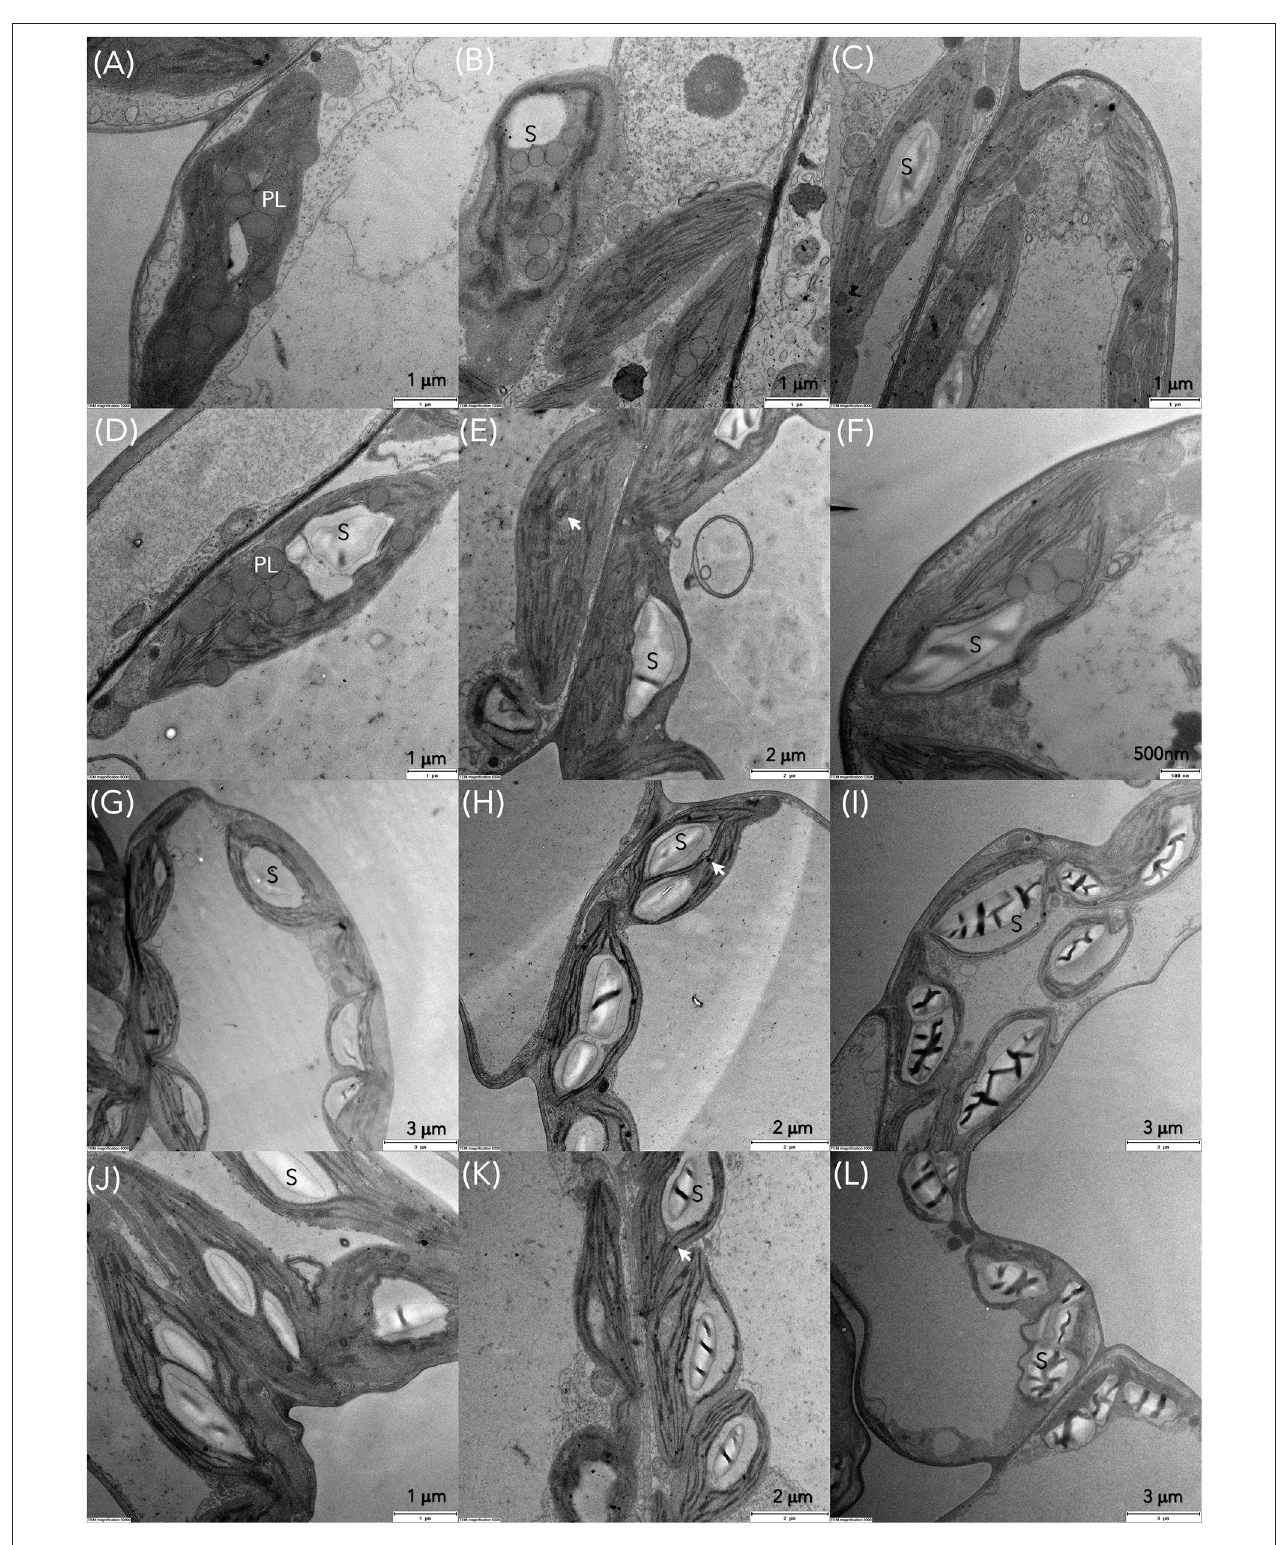
FIGURE 7 | Transmission electron microscopy (TEM) images of S. polyrhiza mother fronds (MFs) after exposure for 6, 24, and 72h to Cd concentrations (A–C) C1 and (D–F) C3 and granddaughter fronds (GDFs) after 6, 24, and 72h of exposure to (G–I) C1 and (J–L) C3Cd. PL and black arrow represent plastoglobules, S is starch